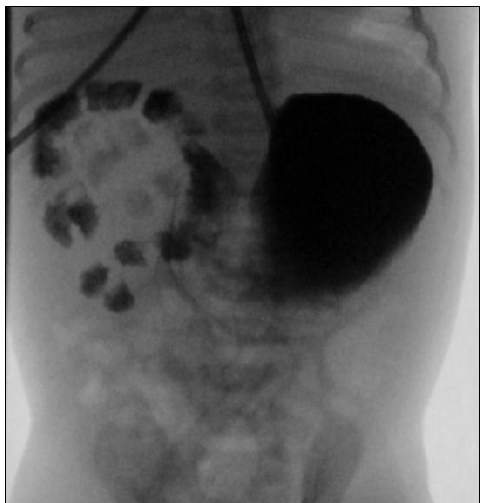
Figure 3: Delayed UGI films showing a duplication cyst of the jejunum.